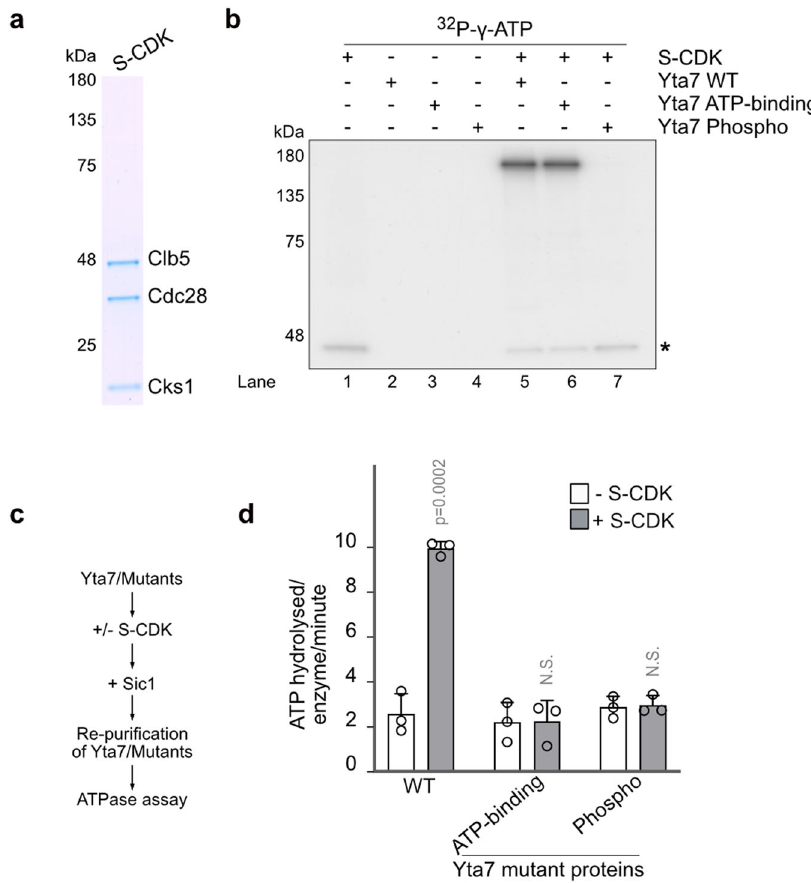
Fig. 4 S-CDK phosphorylation stimulates ATPase activity of Yta7. a SDS-PAGE and Coomassie staining of puri fi ed S-CDK from nocodazole-treated cells. b In vitro kinase assay using puri fi ed S-CDK with both WT and mutant forms of Yta7 protein (WT, ATP-binding, Phospho) (Fig. 2b, Supplementary Fig. 2b). Incorporation of [ 32 P- γ ]-ATP into Yta7 by S-CDK was visualized using autoradiography after separation by SDS-PAGE. Asterisk shows auto- phosphorylation of S-CDK. c Reaction scheme of the determination of the ATPase activity of Yta7. Puri fi ed Yta7 variants were pre-phosphorylated with S-CDK (omitted for controls) and treated with inhibitor Sic1 before re-puri fi cation. d ATP hydrolysis rates by re-puri fi ed Yta7 WT and Yta7 ATP-binding- mutants and Phospho-mutants in the presence of H3 acetylated chromatin was obtained by measuring the oxidation of NADH, which was used to regenerate hydrolyzed ATP. Error bars depict standard errors of three independent experiments. Mean values and standard deviations (S.D.) in d were obtained from three biological replicates. P -values were obtained by using two-tailed unpaired t -test calculations. N.S. means statistically non-signi fi